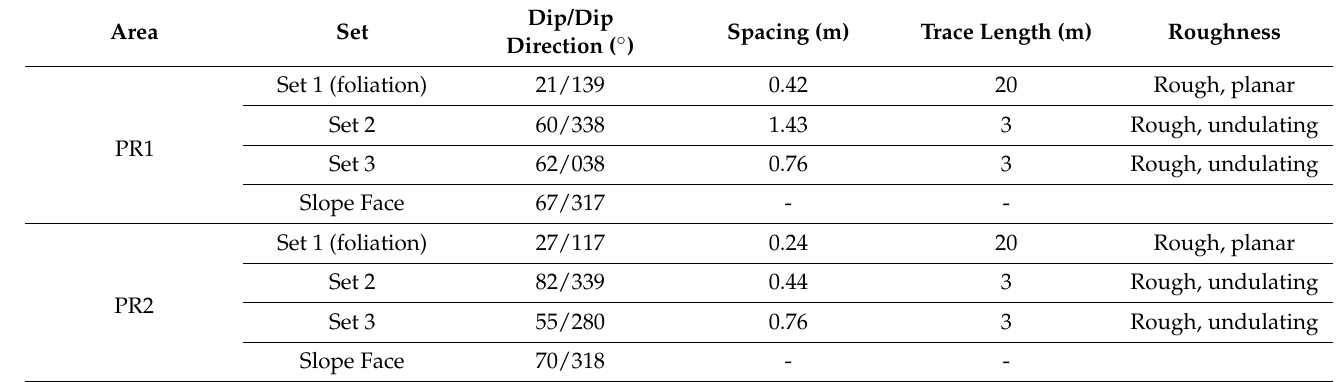
Table 7. Geometric characteristics of the discontinuity sets of PR1 and PR2 areas in Slope-1.